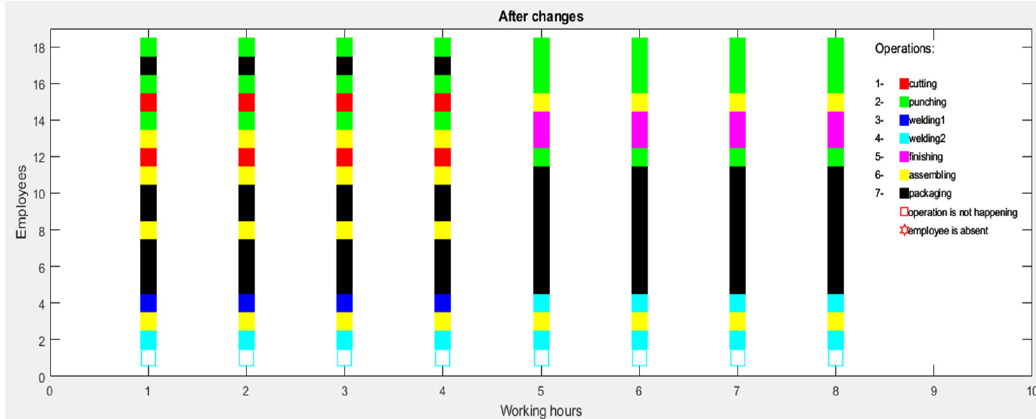
Figure 7. Data after changes, 1st case.